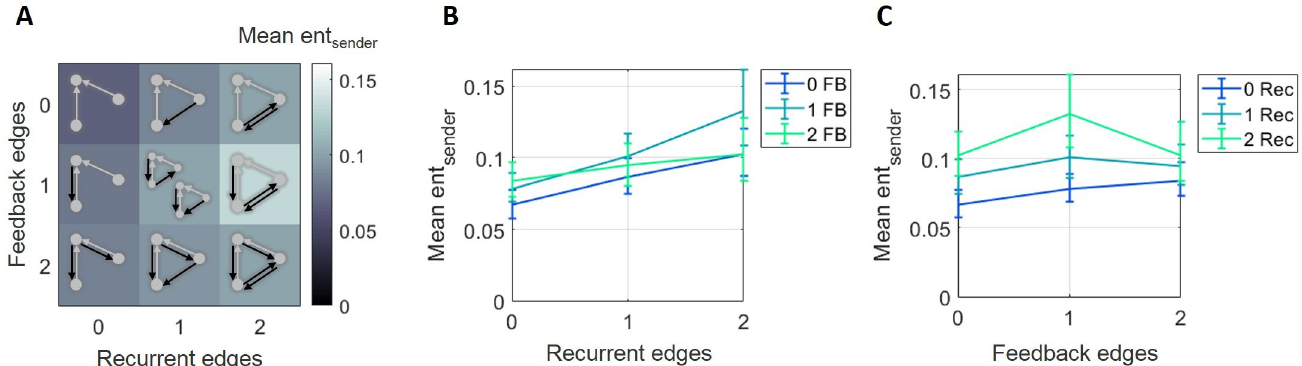
Fig 7. Sender entropy increased with greater recurrence and greater feedback. (A) Mean sender entropy increased with the number of recurrent edges and with the number of feedback edges in motifs. (B) Curves representing rows shown in A, plotted with errorbars computed across networks, show that sender entropy increased as the number of recurrent edges increased. (C) Curves representing columns shown in A, plotted with errorbars computed across networks, show that sender entropy increased as the number of feedback edges increased. Errorbars are 95% bootstrap confidence intervals around the mean.